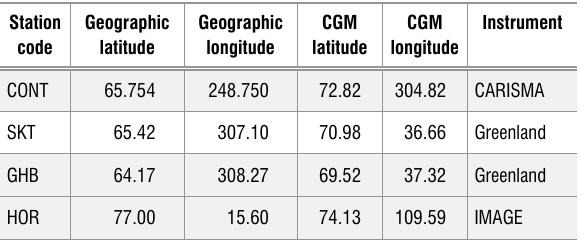
calculated from different beams and range gates of the radars in which a given field line resonance was maximum, as shown in Figure 9 for Goose Bay. Similar analyses of Saskatoon and Þykkvibaer radars were performed, but are not shown here due to space constraints. The phase of the resonance was measured across the field of view at constant magnetic latitude, yielding the phase versus longitude relations shown in Figure 10. The slope of these relations yields the azimuthal wave number, m : 12±2.1 for Saskatoon, 13±2.9 for Goose Bay and 19±5.0 for Þykkvibaer. The m -value and the resonance frequency were used to calculate the azimuthal phase velocities. The m number changes as we cross magnetic longitude. The azimuthal phase velocity is given by , Equation 1